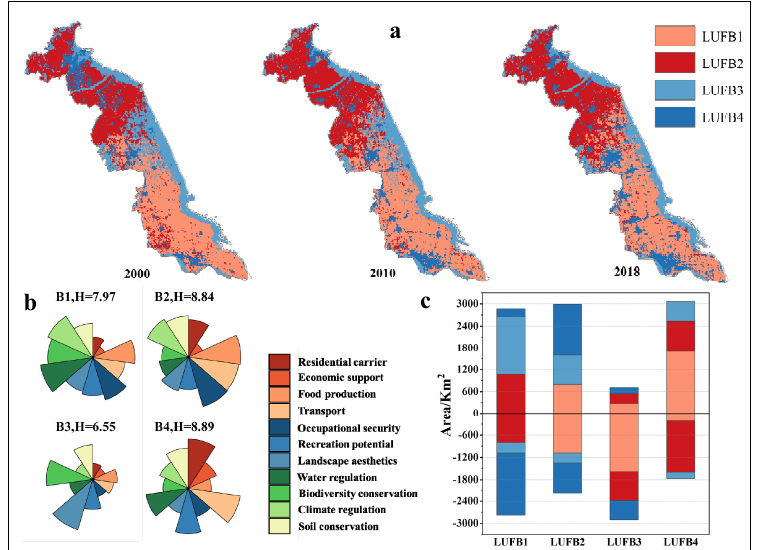
Figure 4. The mutual transfers among LUF bundles over time ( a , c ) and the diversity in each bundle ( b ). ( a ) The map shows spatial distributions of bundled LUFs over time; ( b ) The Nightingale Rose diagram shows the number of effective LUFs provided by each of the four bundles and their advantageous functions; ( c ) The histogram reveals the main trajectories of changes that provide the source and transfer of each bundle from 2000 to 2018. The positive values represent the area where the other three LUFBs transform into this LUFB, while the negative values represent the area where this LUFBs transform into the other three LUFB. Table 2. The LUF bundles area proportions: 2000, 2010 and 2018.